Question: Does the figure show an increasing or a decreasing trend?
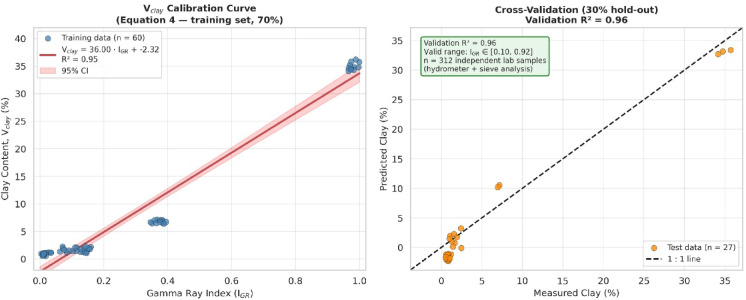
Answer: increasing